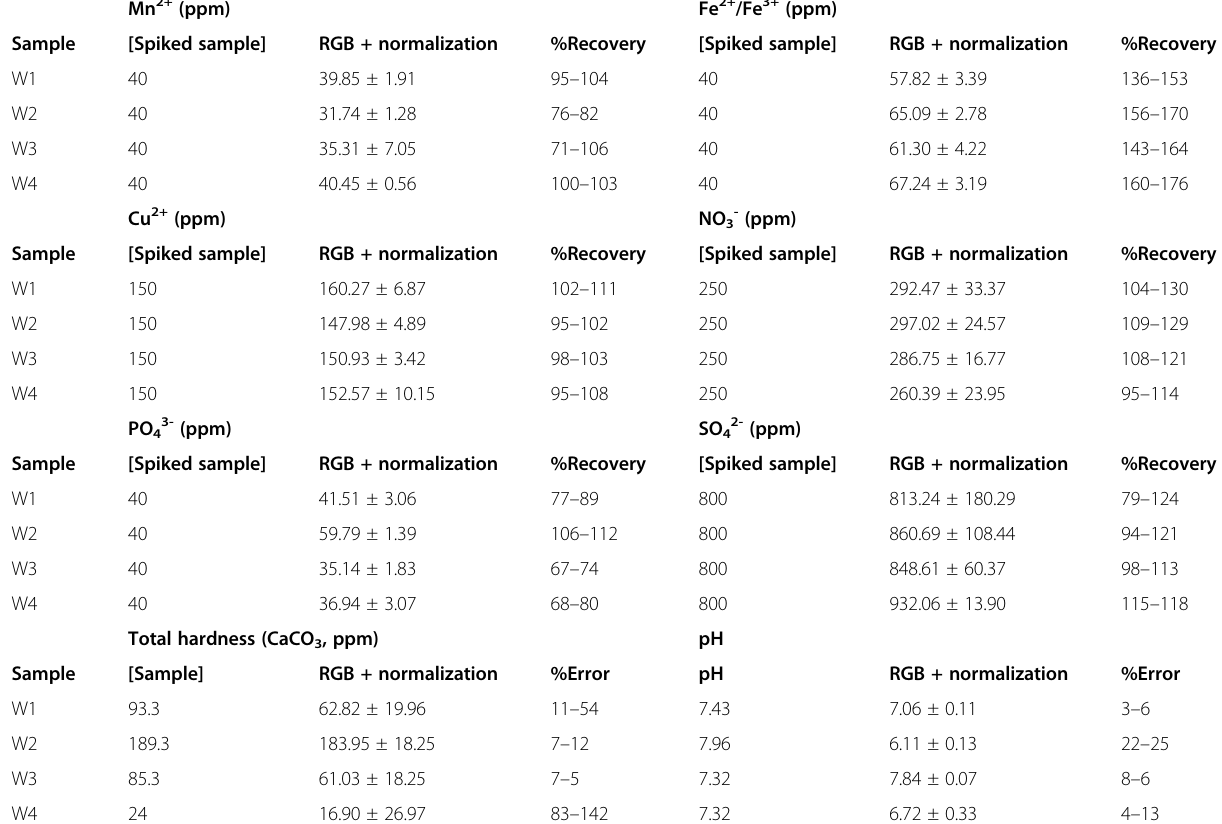
Table 3 Predictive results of samples using RGB color model after normalization Mn 2+ (ppm) Fe 2+ /Fe 3+ (ppm)